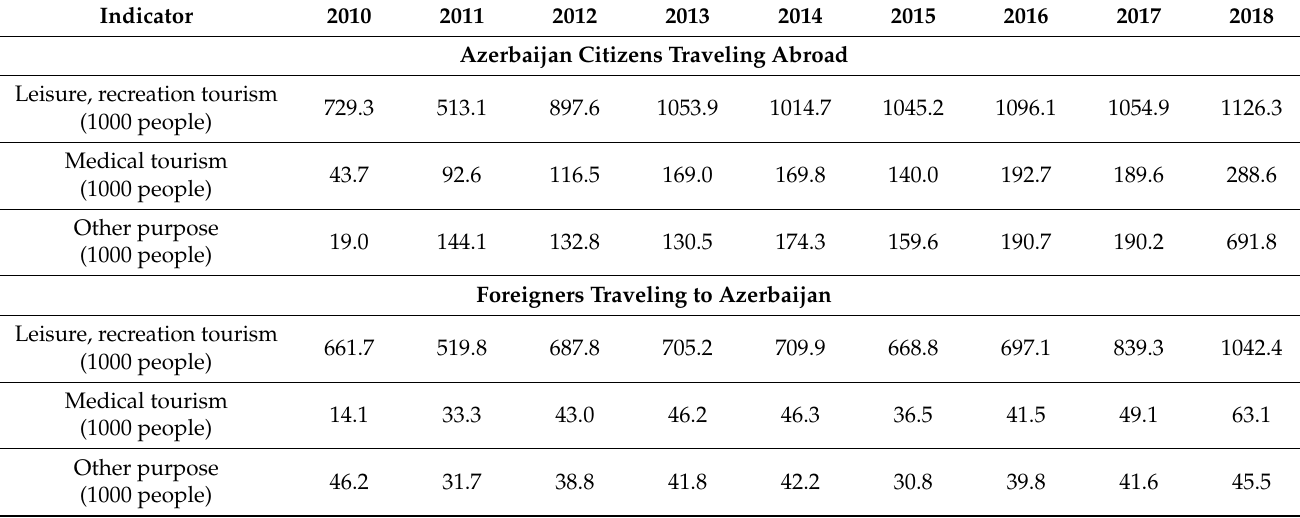
Table 2. Breakdown of foreigners arriving to azerbaijan and azerbaijan citizens traveling abroad by purpose of trip.